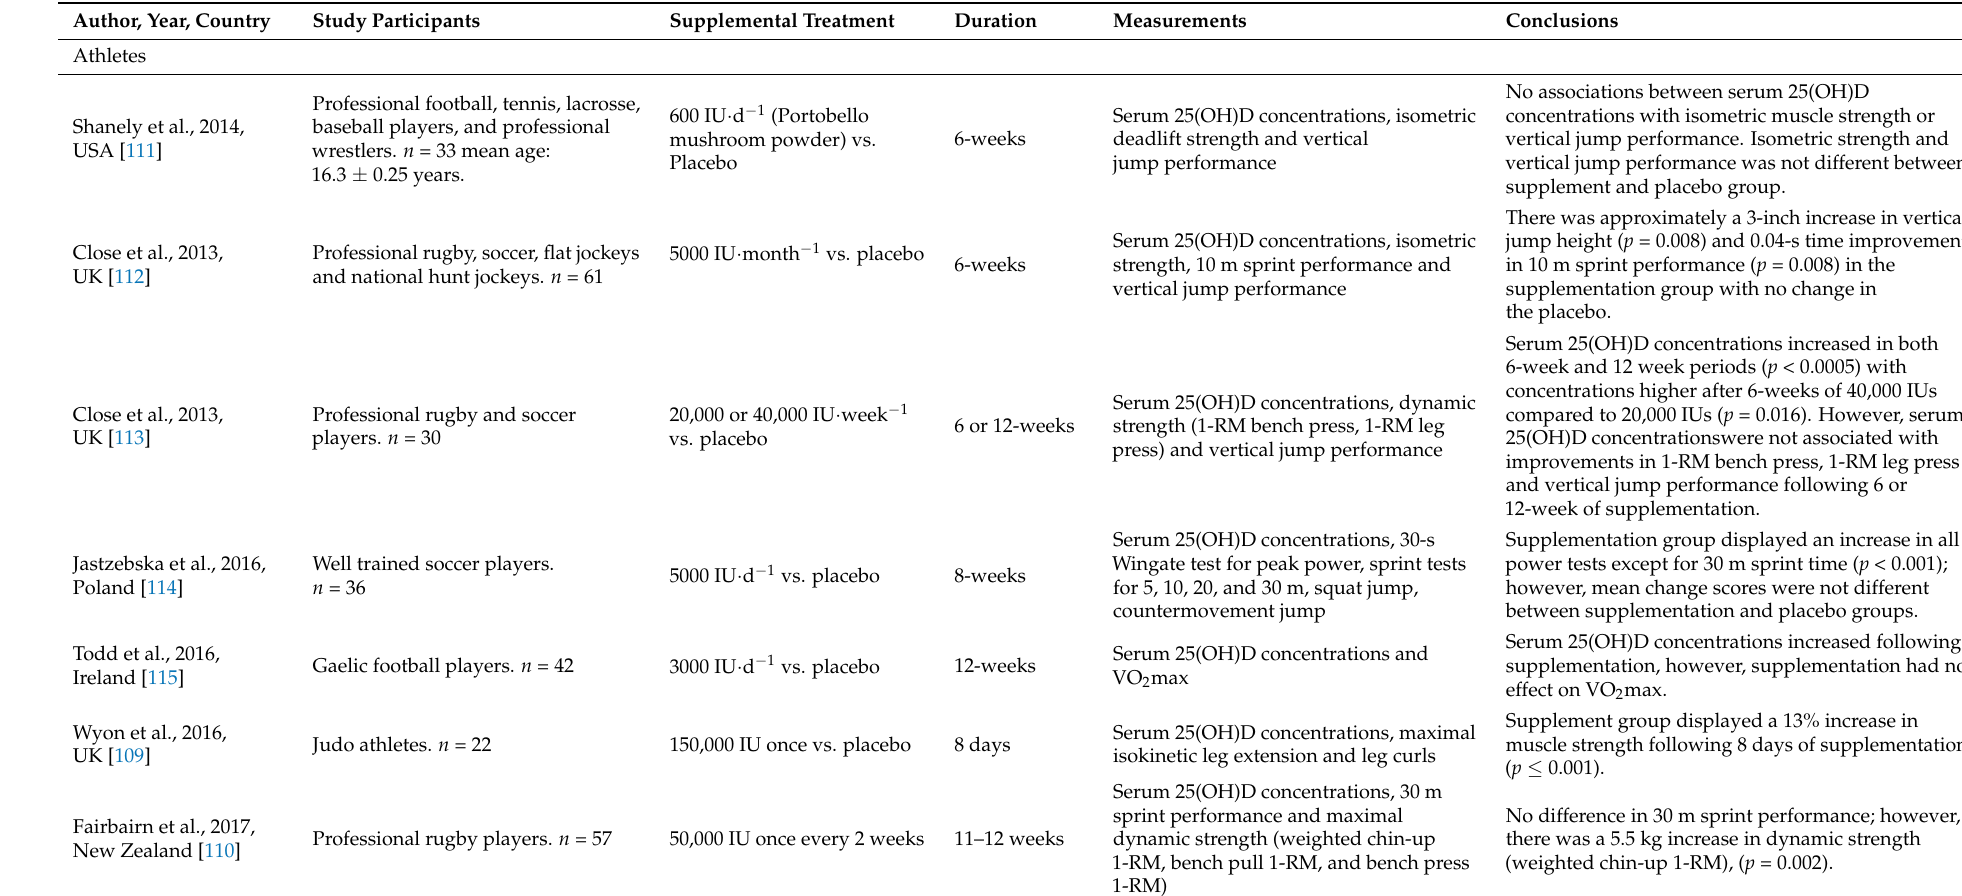
Table 2. Experimental studies examining the effects of vitamin D supplementation on muscle